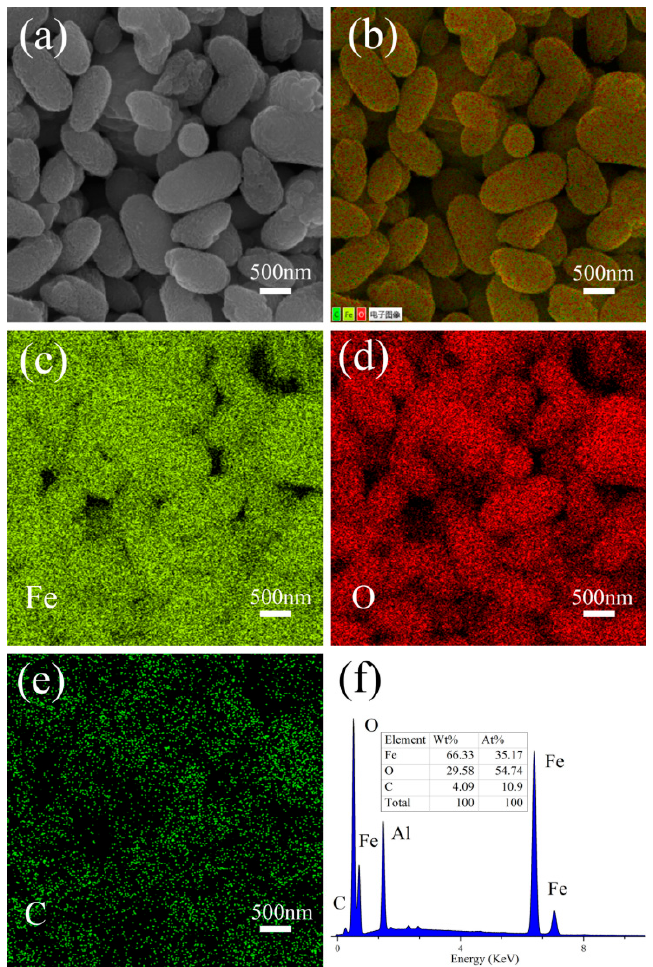
Figure 5. Energy dispersive X-ray spectrometry (EDS) element mapping of α -Fe 2 O 3 @C nanoparticle composite. ( a ) The original FESEM images; ( b ) the total element mapping; ( c ) the Fe K α 1 mapping; ( d ) the O K α 1 mapping; ( e ) the C K α 1 mapping; ( f ) the EDS spectra of α -Fe 2 O 3 @C nanoparticle.